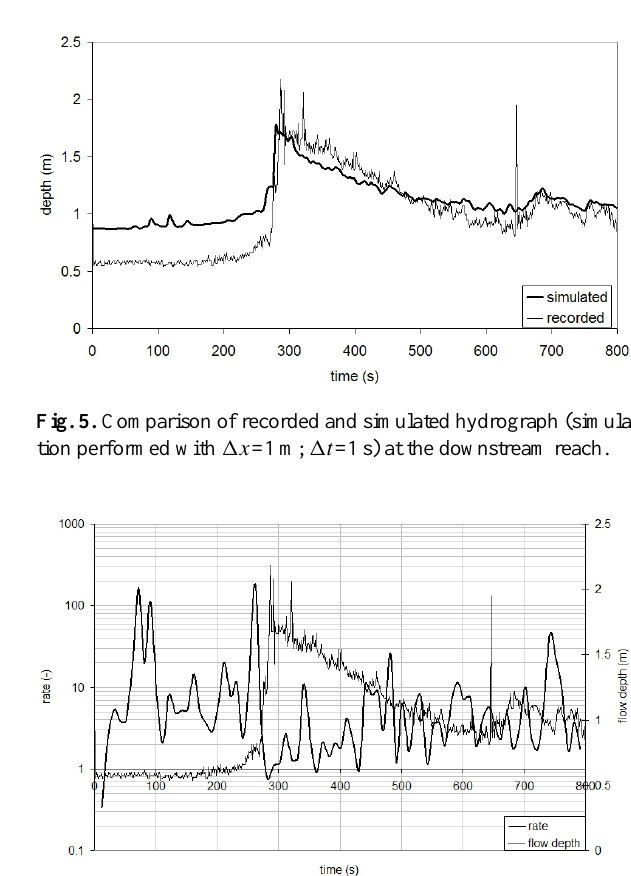
Fig. 6. Rate given by Eq.